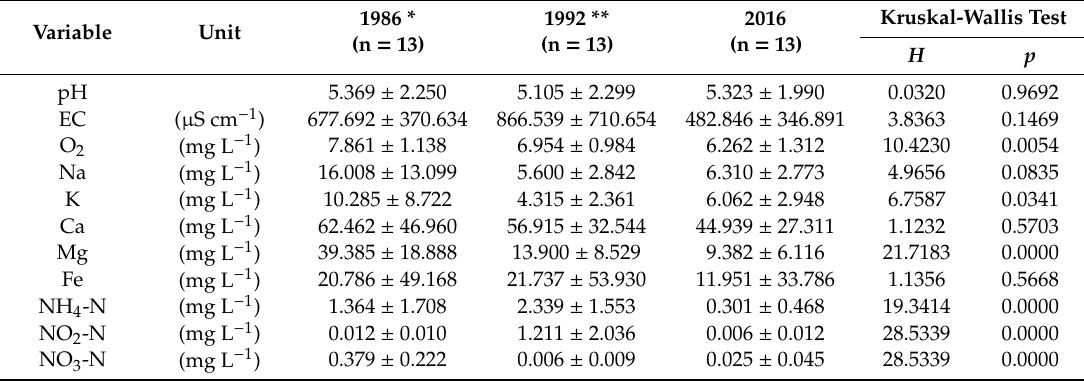
Table 2. Physicochemical characteristics (Mean ± SD) of the analyzed lakes and the Kruskal-Wallis test across the years of study * by J˛edrczak [24] and ** by Jachimko